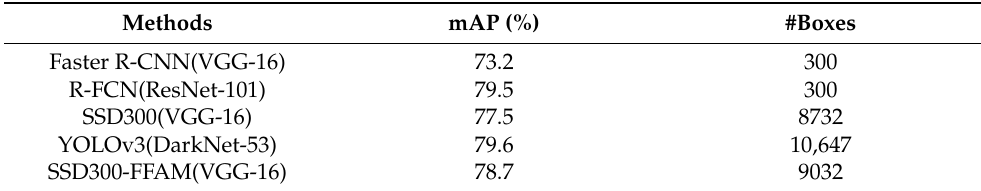
Table 5. Comparison of the proposed SSD300-FFAM with state-of-the-art detectors on the Pascal VOC 2007 test set. All models were trained with VOC 2007 trainval and VOC 2012 trainval.